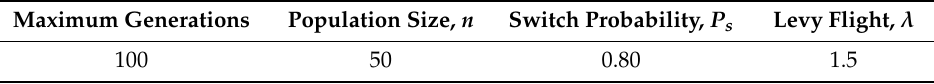
Table 3. Constraints of the flower pollination algorithm